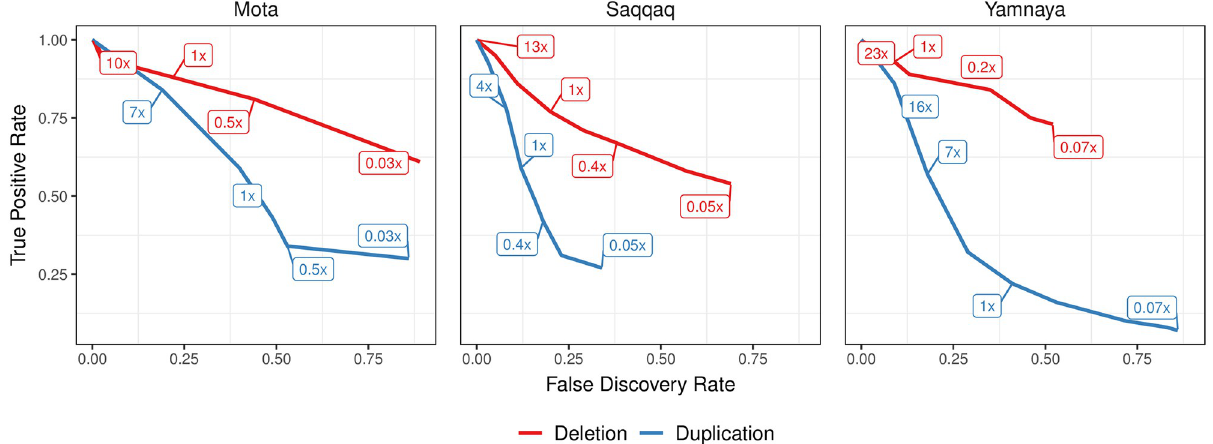
Fig 4. TPR vs FDR curves for deletion and duplication predictions of CONGA. Here, we use Mota, Saqqaq and Yamnaya genomes down-sampled to various depths from their original coverages of 9.6 × , 13.1 × and 23.3 × , respectively. The numbers inside boxes show the down-sampled coverage values. We calculated TPR and FDR for down-sampled genomes assuming that our CONGA-based predictions with the original genomes (full data) reflect the ground truth. These predictions, in turn, were made using modern-day CNVs as candidate CNV list. The purpose of the experiment was to evaluate accuracy at lower coverage relative to the full data, as well as to compare performance across different real genomes (Methods).